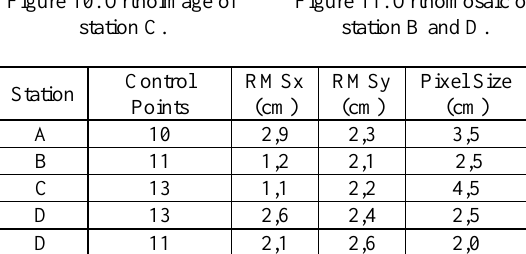
Figure 10. Orthoimage of station C.